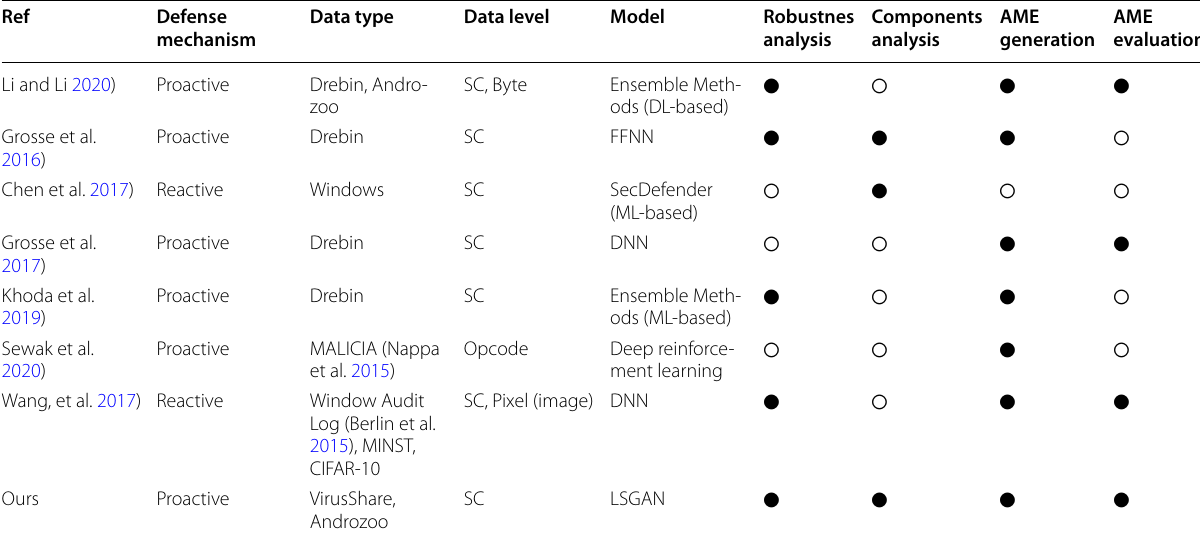
a The Defense Mechanism includes proactive and reactive. The Robustness Analysis aims to evaluate whether the defense model can recognize the AME of other attack models. The Component Analysis is used to evaluate whether the reference paper makes components analysis. The AME generation exposes whether the defense model can generate AME, and normally, a proactive defense mechanism will generate the AME